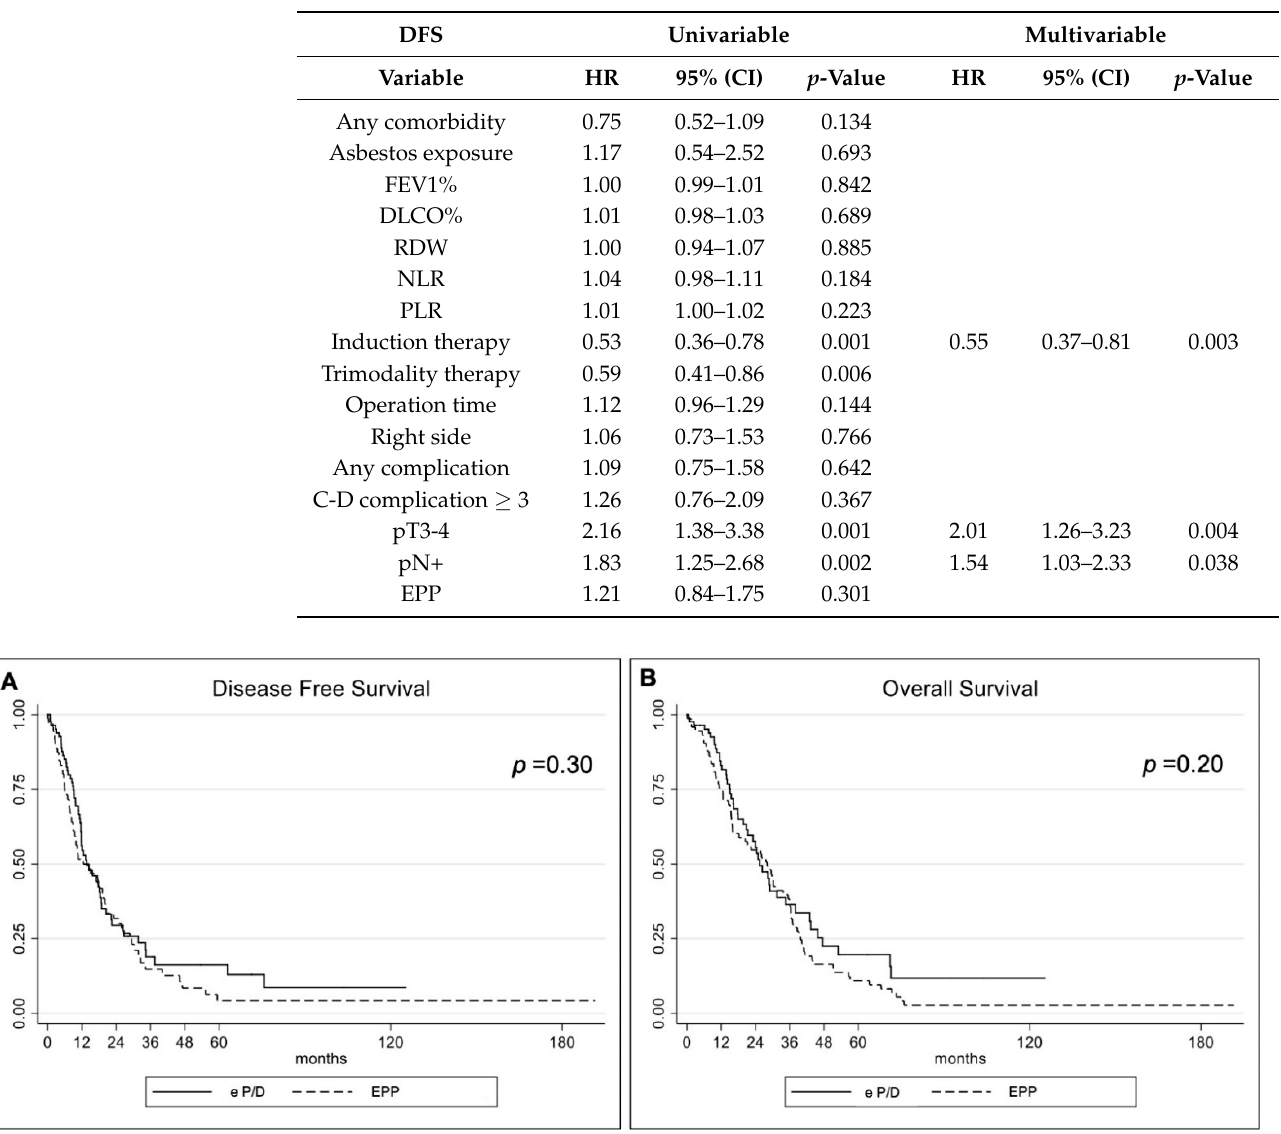
Figure 1. ( A ) Disease-free survival and ( B ) overall survival curves for extrapleural pneumonectomy (EPP) and extended pleurectomy and decortication (e/PD).